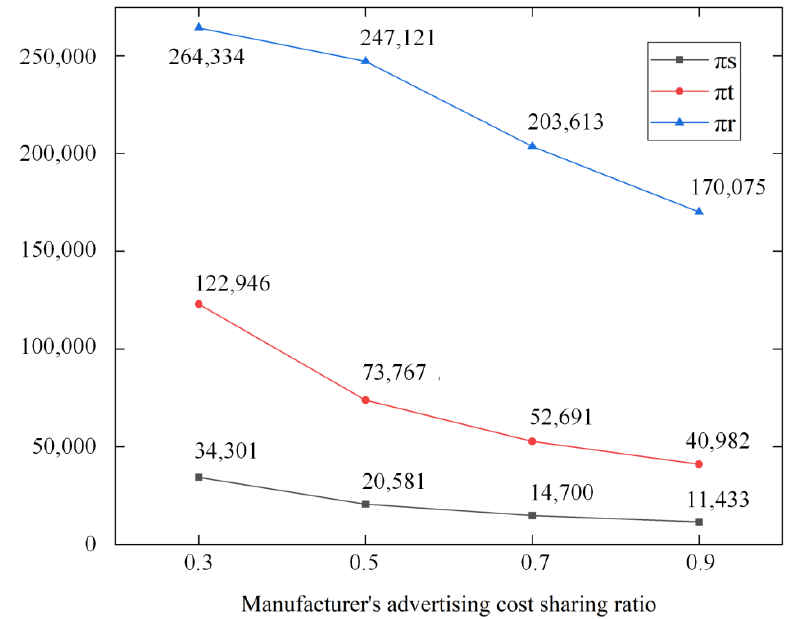
Figure 6. The impact of the manufacturer’s advertising cost-sharing ratio on the profits of all parties in the supply chain.